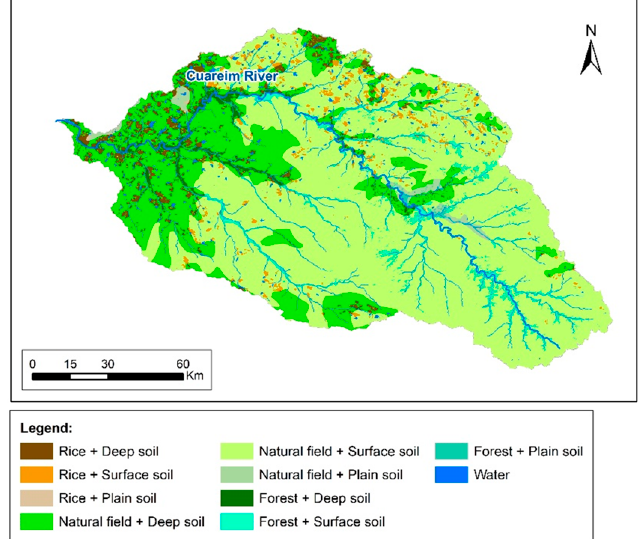
Figure 6. Hydrological response units (HRUs) defined for implementing the large-scale (MGB-IPH) model in the Cuareim/Quaraí watershed.